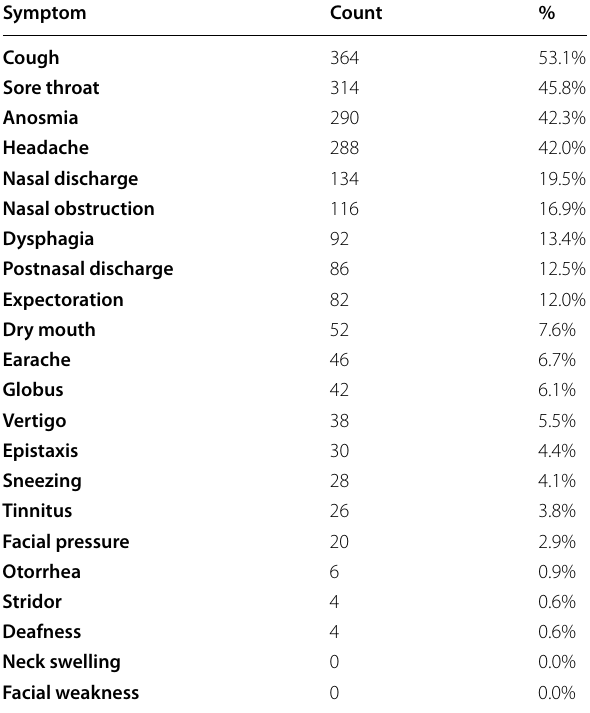
Table 2 Prevalence of otorhinolaryngological symptoms